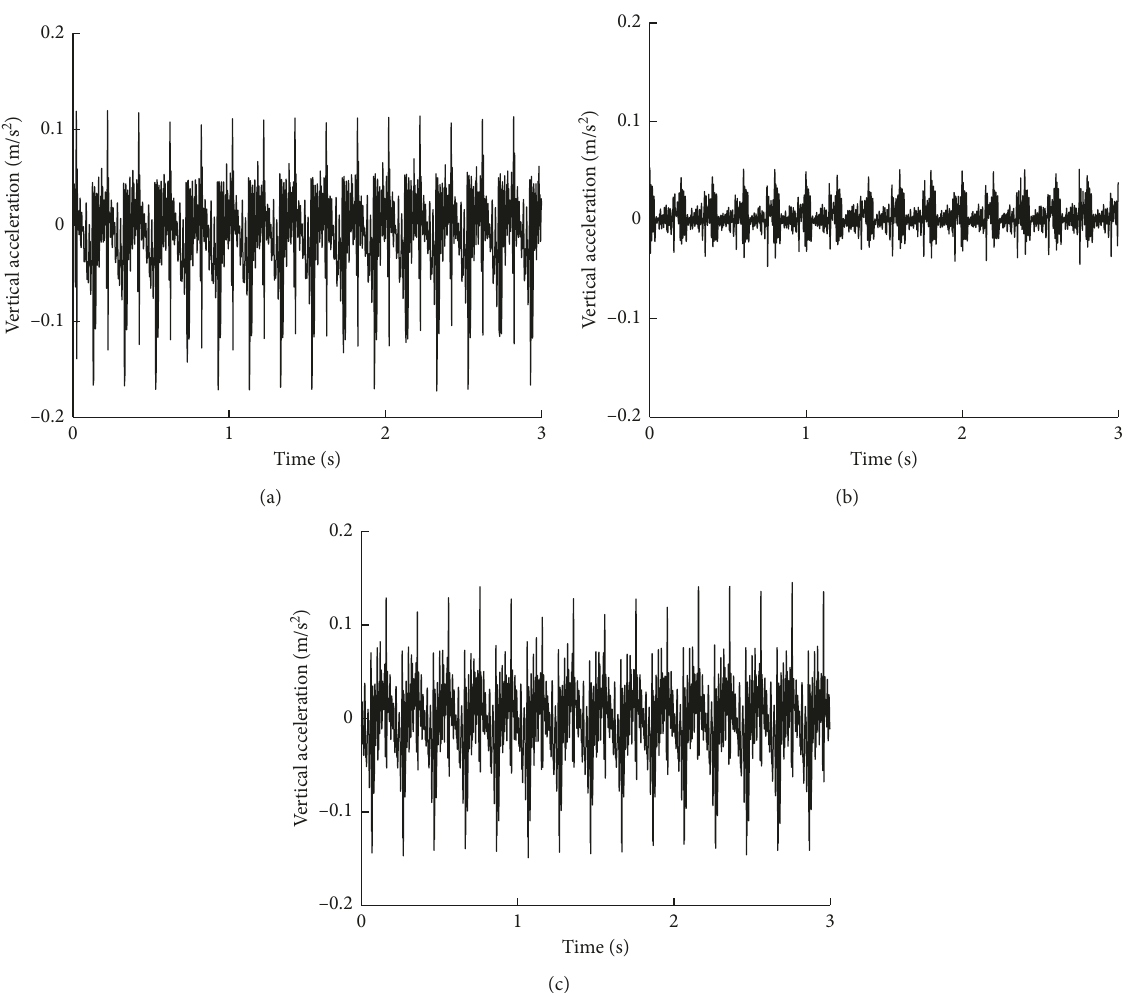
Figure 11: Time-history curve of vertical vibration acceleration of the test point A3. (a) The upper layer of the subgrade bed in normal condition (stage 1). (b) The upper layer of the subgrade bed in mud pumping (stage 2). (c) The model with mud pumping after reinforcement (stage